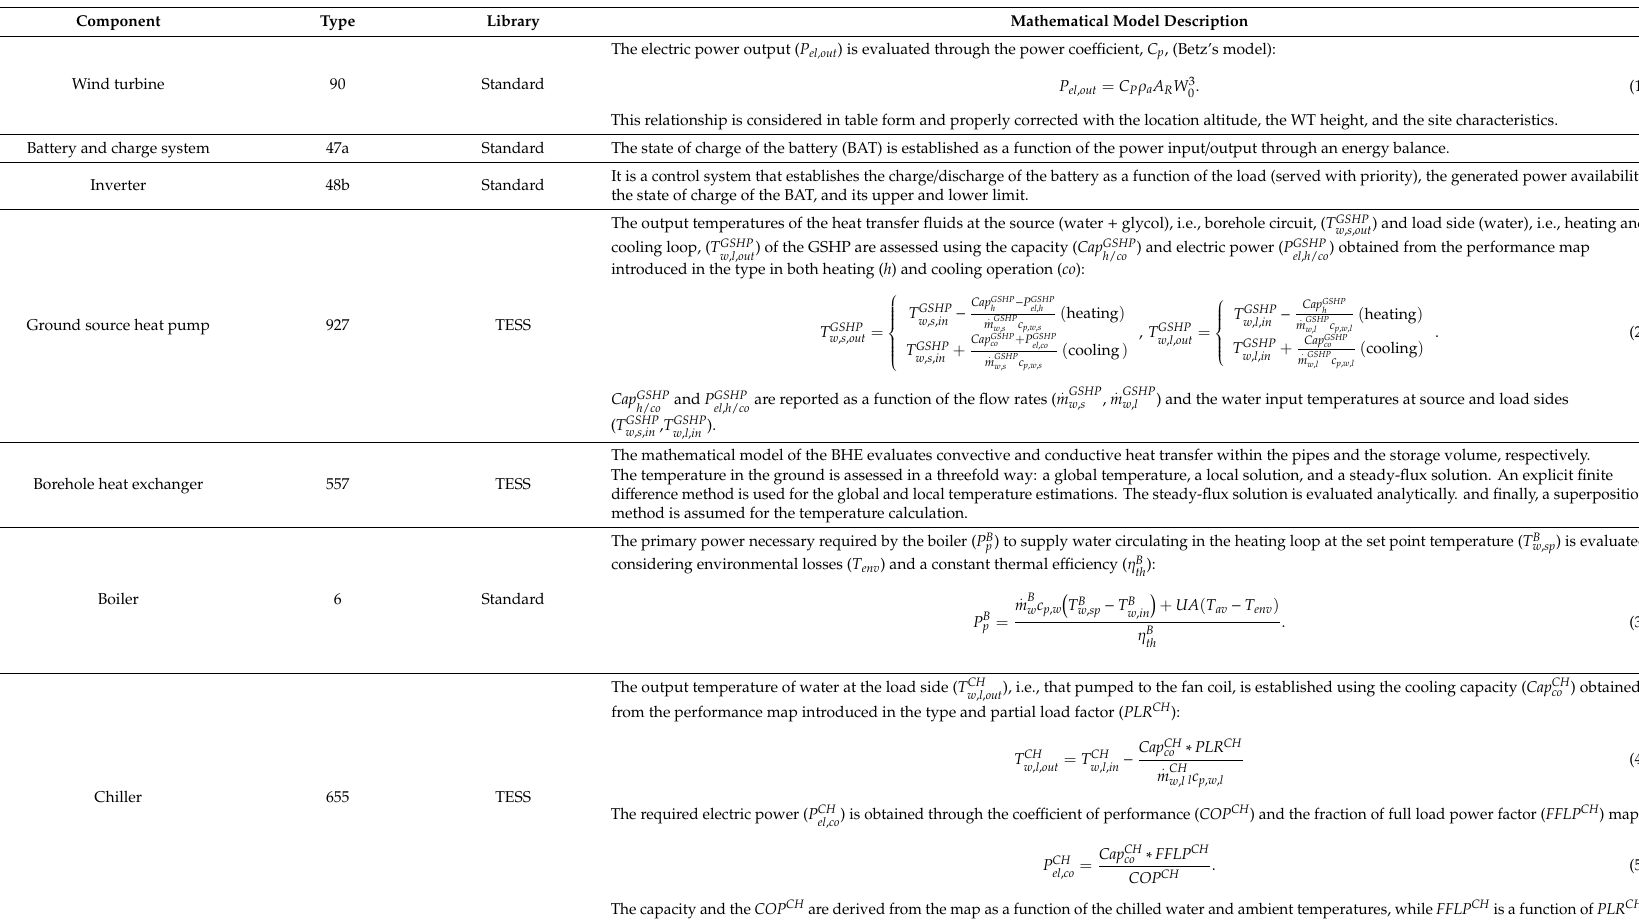
Table 4. Main components of the conventional system (CS) and proposed system (PS) and their